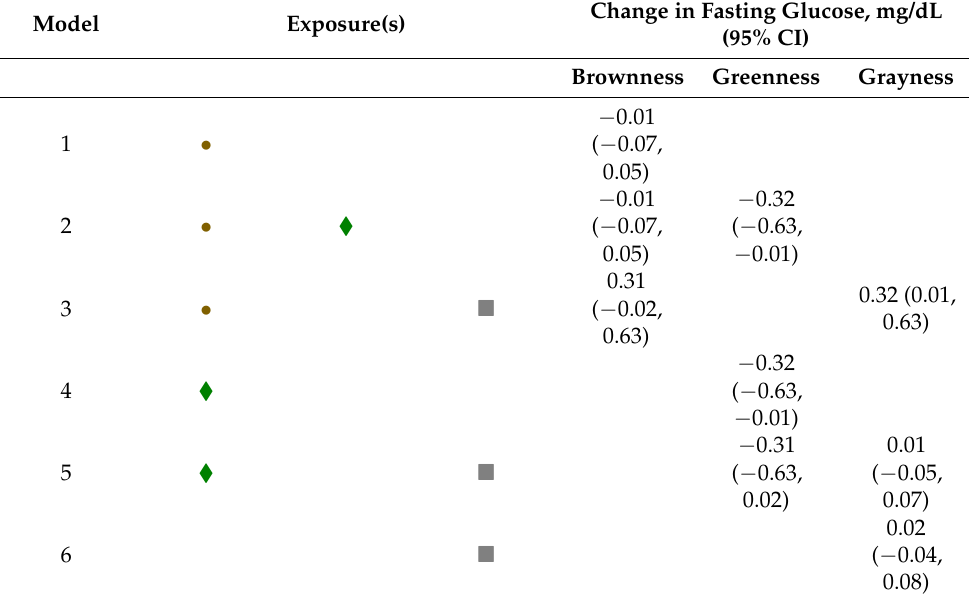
Table 2. Associations between fasting glucose levels and greenness, brownness and impervious surface area. Results shown are from linear regression models using the 250 m buffer and that included each exposure measure separately, and models that included combinations of two of the exposure measures. Change in Fasting Glucose, mg/dL Model Exposure(s) (95% CI) Brownness Greenness